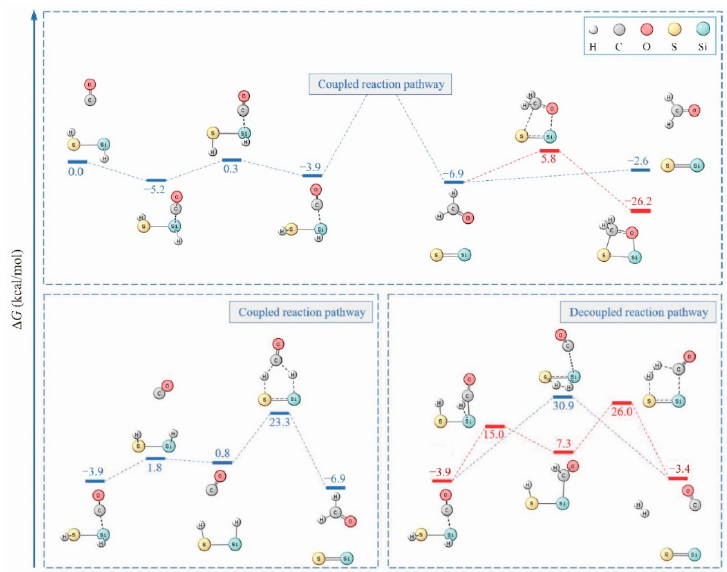
Figure 3. Reaction profiles for HSiSH + CO, with coupled and decoupled reaction pathways illus- trated in the lower panel (all energetics were refined by the CCSD(T) method).